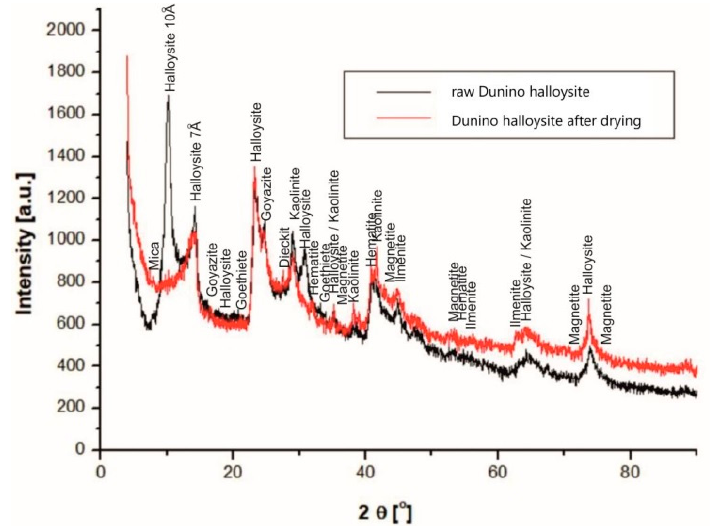
Figure6. X-raydi ff Figure 6. X-ray diffraction (XRD) patterns of raw halloysite and dried halloysite from the Dunino deposit.